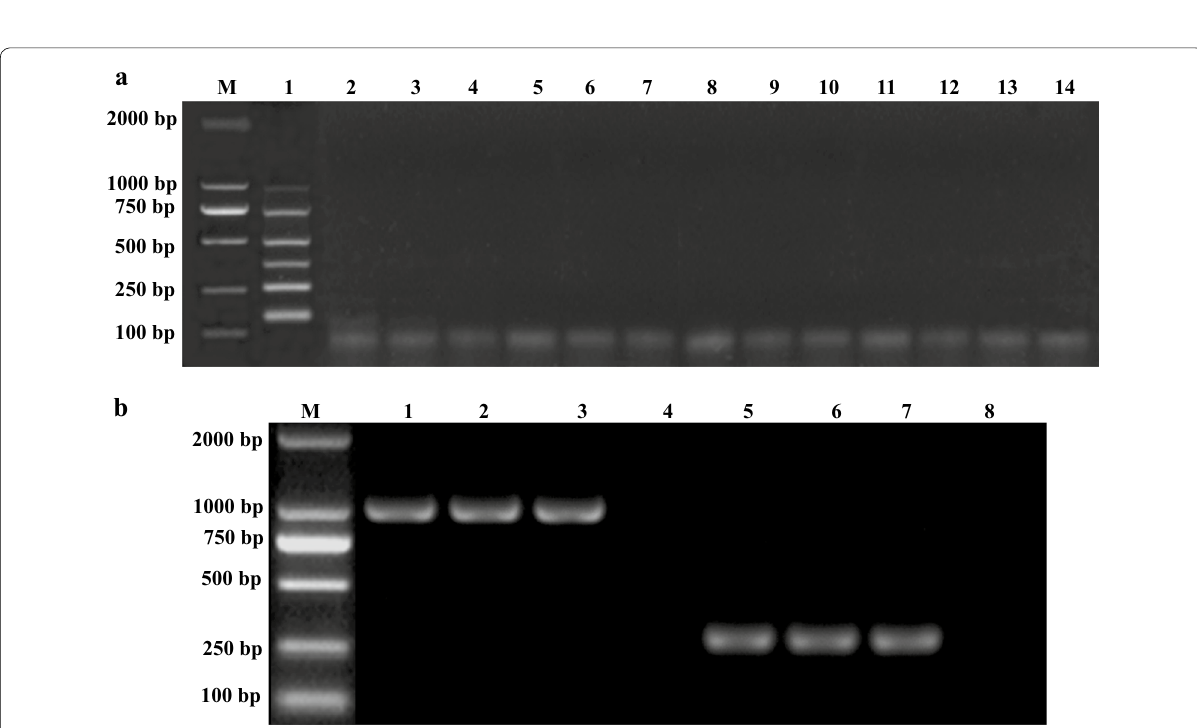
Fig. 4 Determination of specificity of the multiplex PCR. Lane M: 2000 bp DNA marker; a Lane 1: the template of m-PCR contain 6 bacterial genomes as positive control. Lane 2: the template of m-PCR was Klebsiella pneumoniae ; Lane 3: the template of m-PCR was Shigella spp.; Lane 4: the template of m-PCR was Bacillus subtilis ; Lane 5: the template of m-PCR was Bacillus cereus ; Lane 6: the template of m-PCR was Enterococcus faecalis ; Lane 7: the template of m-PCR was Listeria monocytogenes ; Lane 8: the template of m-PCR was Streptococcus suis ; Lane 9: the template of m-PCR was Cryptosporidium baileyi ; Lane 10: the template of m-PCR was Eimeria tenella ; Lane 11: the template of m-PCR was Newcastle disease virus (NDV); Lane 12: the template of m-PCR was Avian Influenza virus H9N2; Lane 13: the template of m-PCR was infectious bursal disease virus (IBDV); Lane 14: Negative control. b Lanes 1–3: the template of m-PCR was O 1 , O 2 and O 78 serotype of avian pathogenic Escherichia coli , respectively; Lanes 5–7: the template of m-PCR was Salmonella typhimurium , Salmonella enteritidis , Salmonella pullorum, respectively; Lanes 4, 8: negative